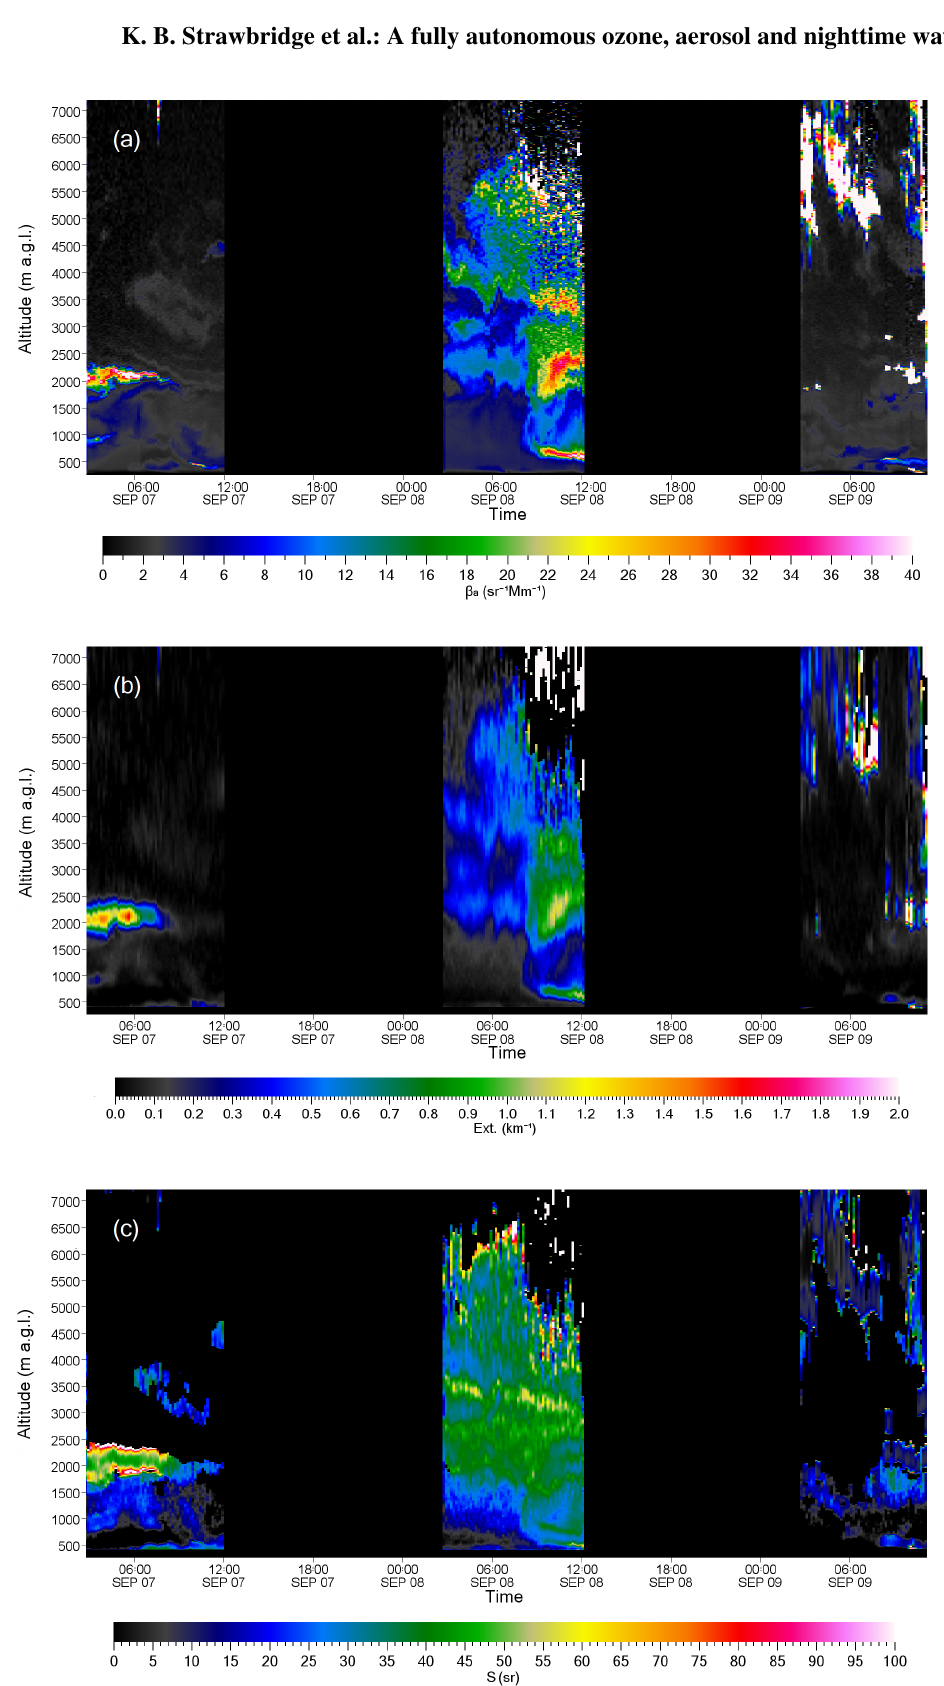
Figure 21. False-color plots of 4–9 September for (a) backscatter coefficient, (b) extinction coefficient and (c) S